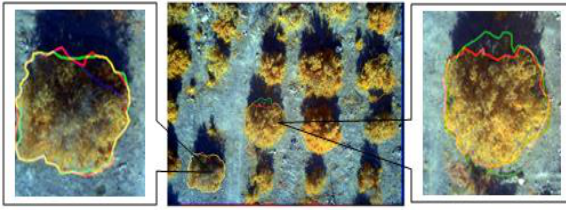
Figure 4. The extracted crown in four bands (Green, Blue, NIR,